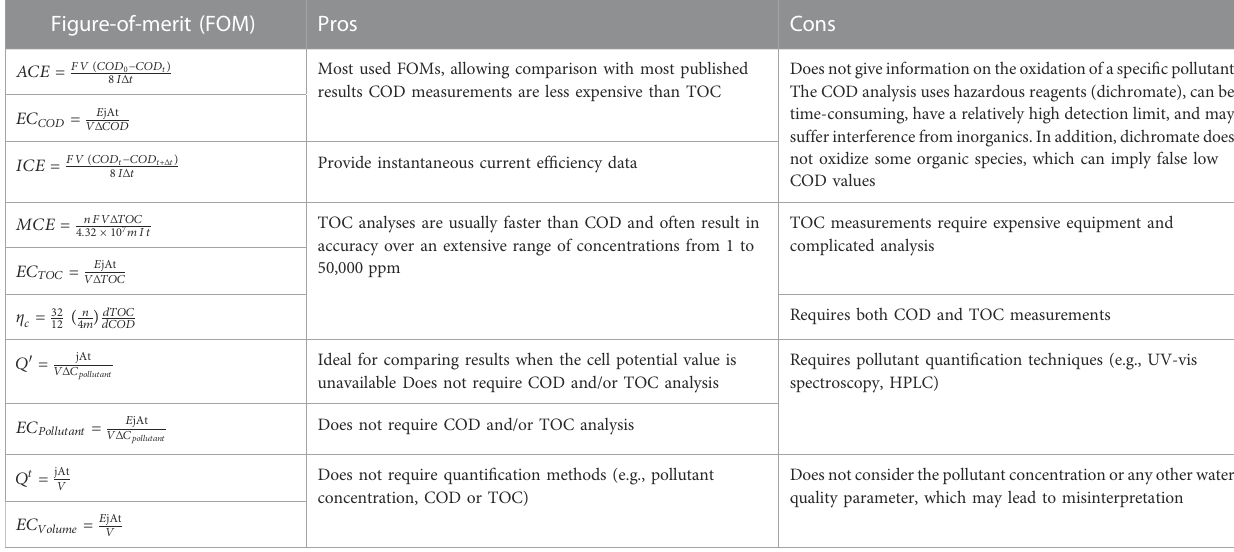
TABLE 4 Summary of fi gures of merit used as performance indicators for pollutant degradation. Figure-of-merit (FOM) Pros